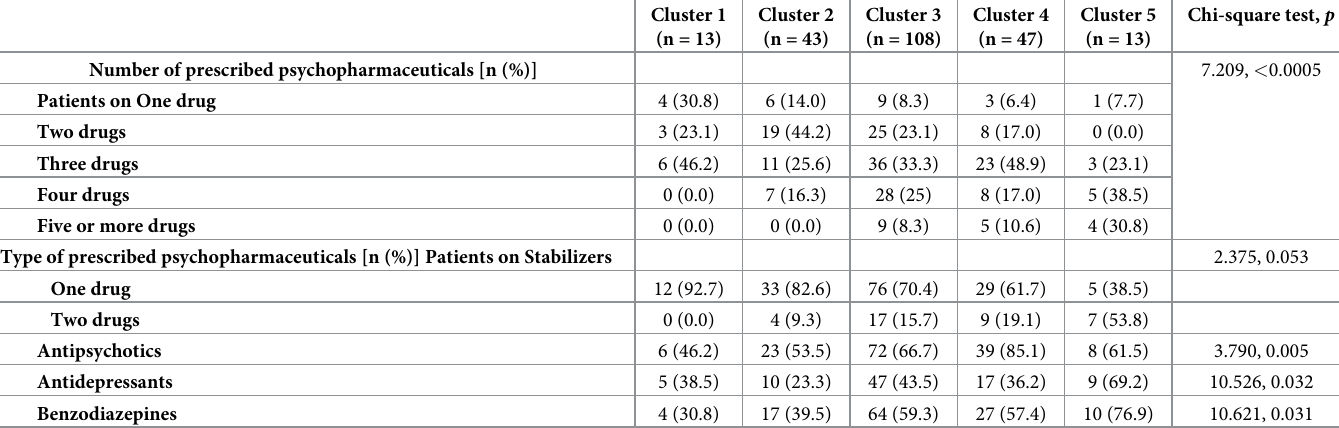
Table 5. Distribution of prescription patterns among the five proposed